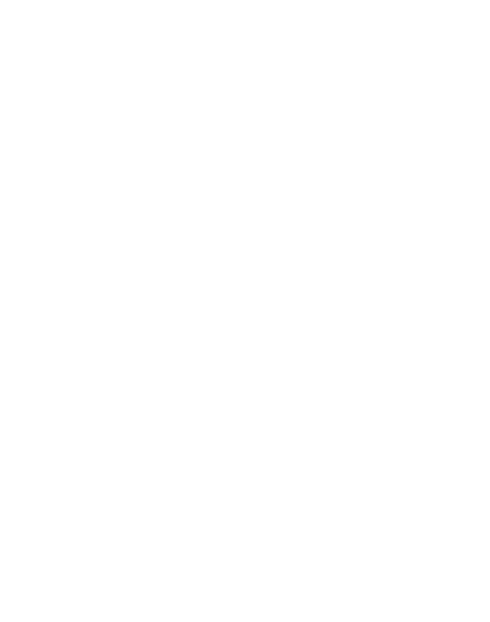
Figure 3 ERCP shows multiple irregular walls of bile ducts without any dominant stricture